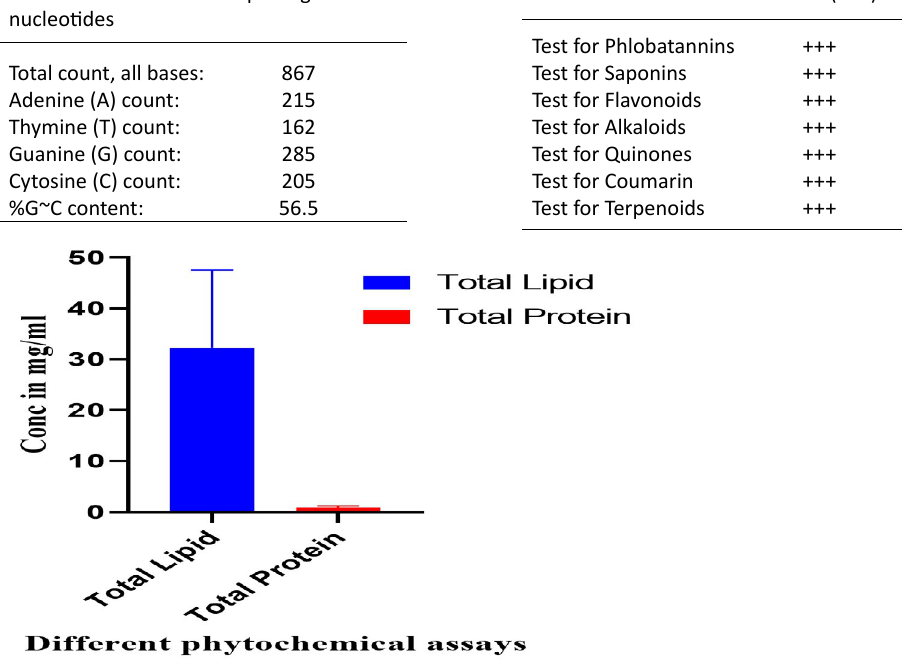
Table 2. The GC% comparing to other nucleotides